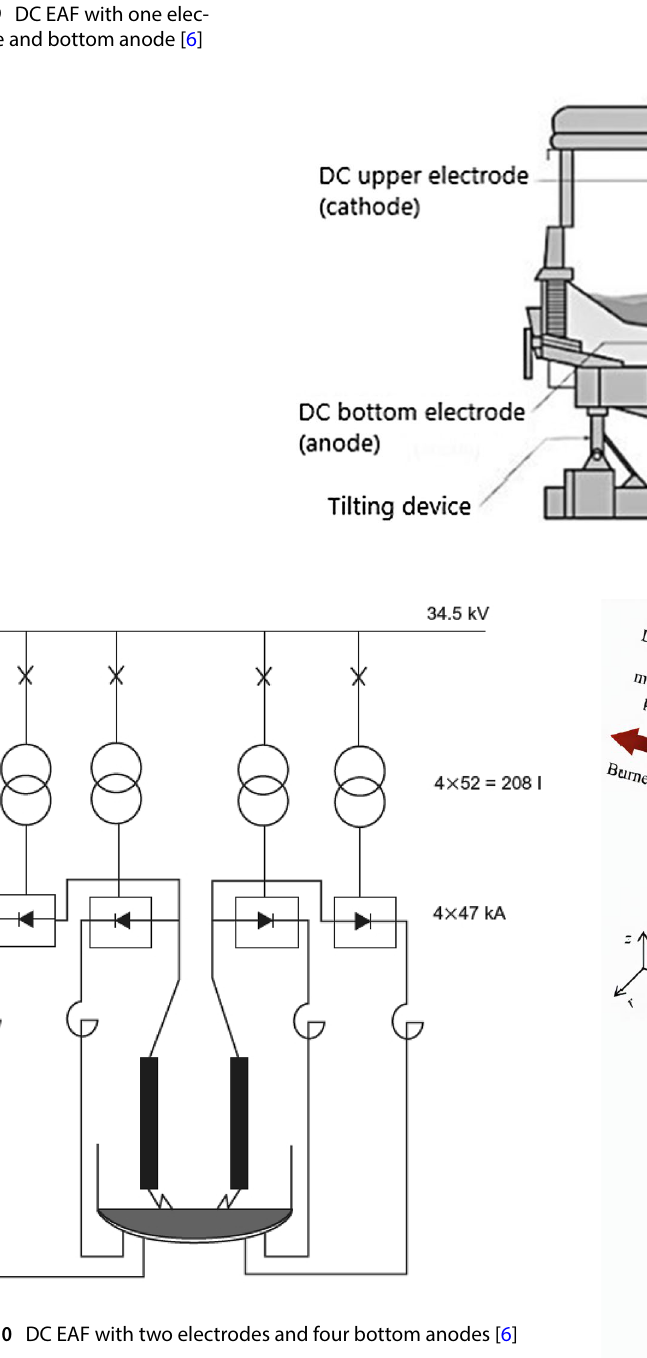
Fig. 10 DC EAF with two electrodes and four bottom anodes [6]